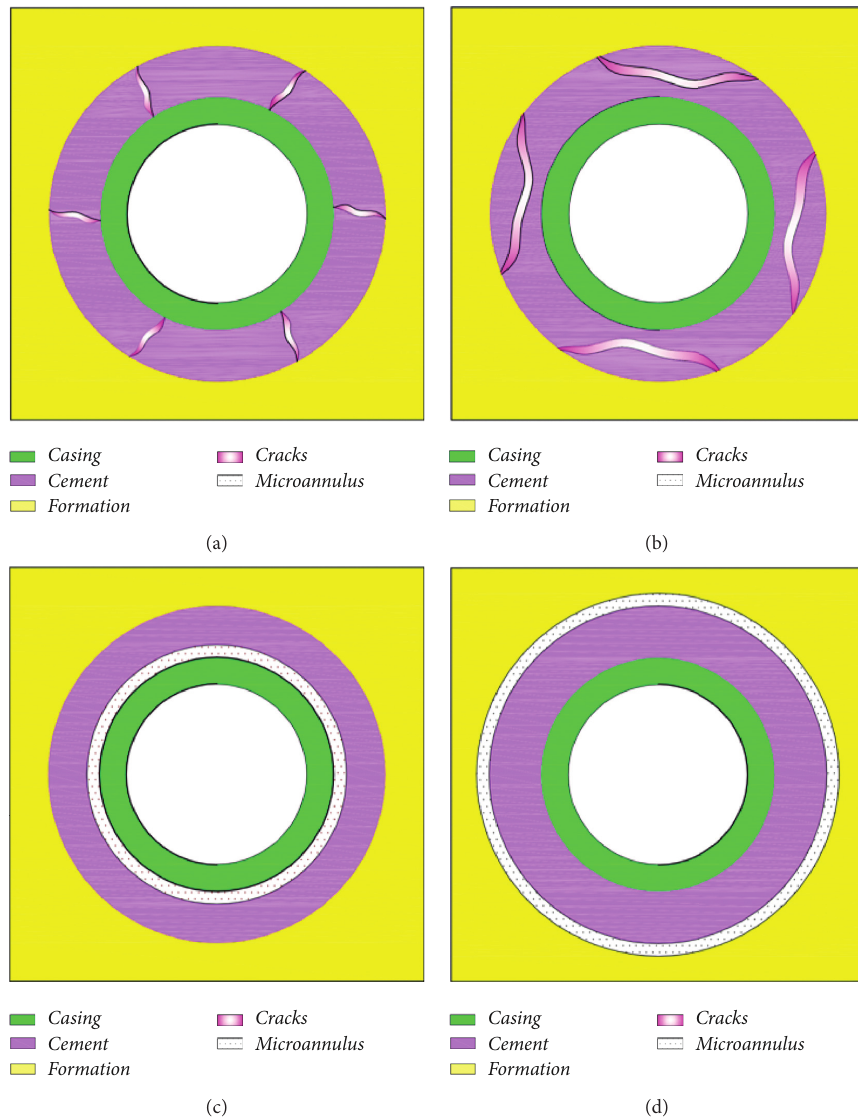
Figure 2: Failure modes of cement. (a) Radical cracks. (b) Shear failure. (c) Inner debonding. (d) Outer